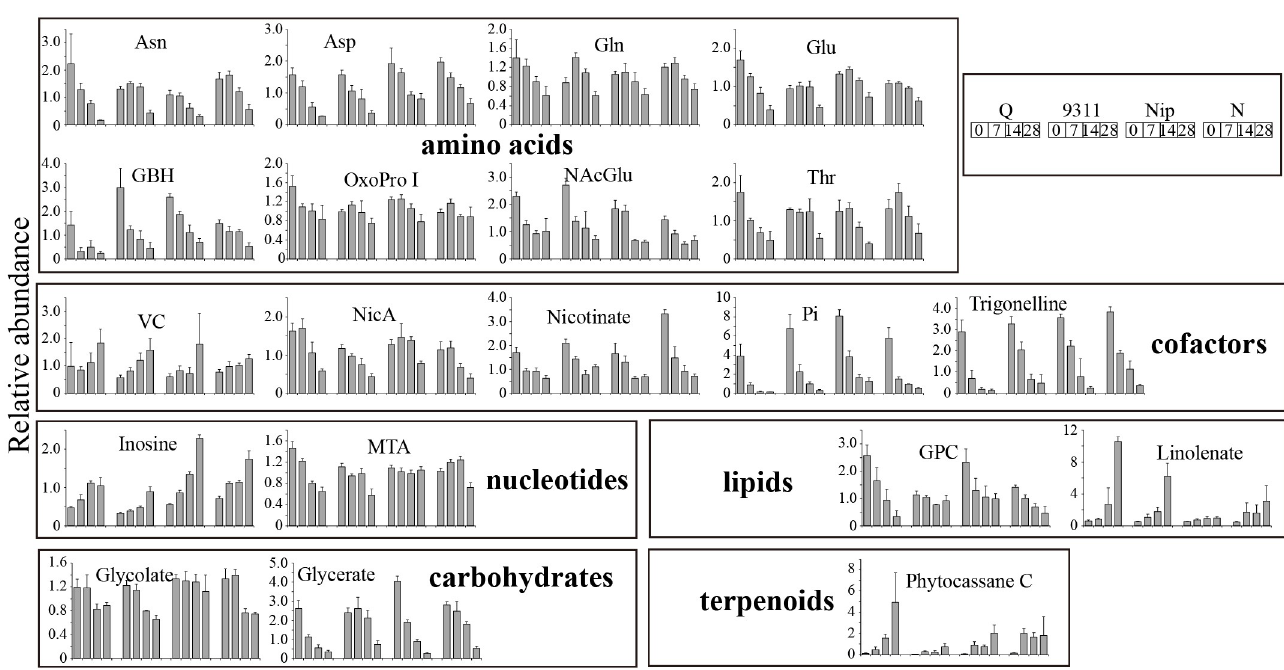
Fig 3. Changes of the well-modeled metabolites following the major pattern of time. For full metabolite names, refer to S2 Table.